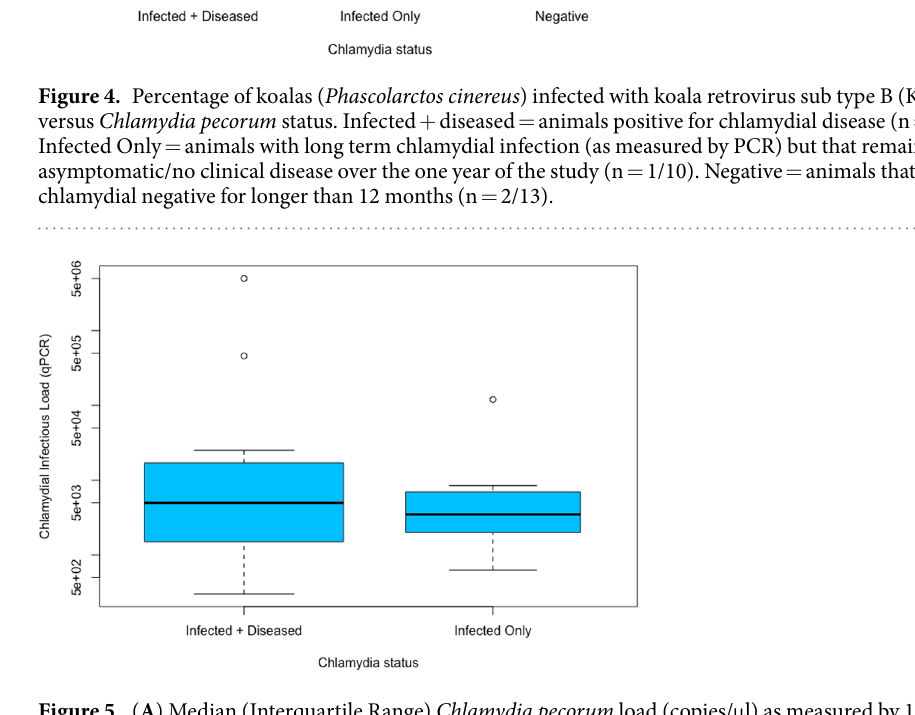
Figure 5. ( A ) Median (Interquartile Range) Chlamydia pecorum load (copies/ μ l) as measured by 16SrRNA qPCR in koalas ( Phascolarctos cinereus ) that progress to chlamydial disease (Infected + Diseased, n = 13) versus koalas that are ‘infected but with no clinical disease’ (Infected Only, n = 10). The width of the boxes is drawn proportional to the square root of the number of data values.